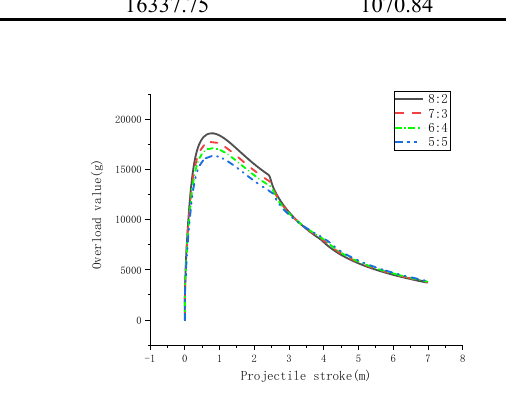
Fig. 4. a-t curves of different mixing ratios of main charge and coating charge.